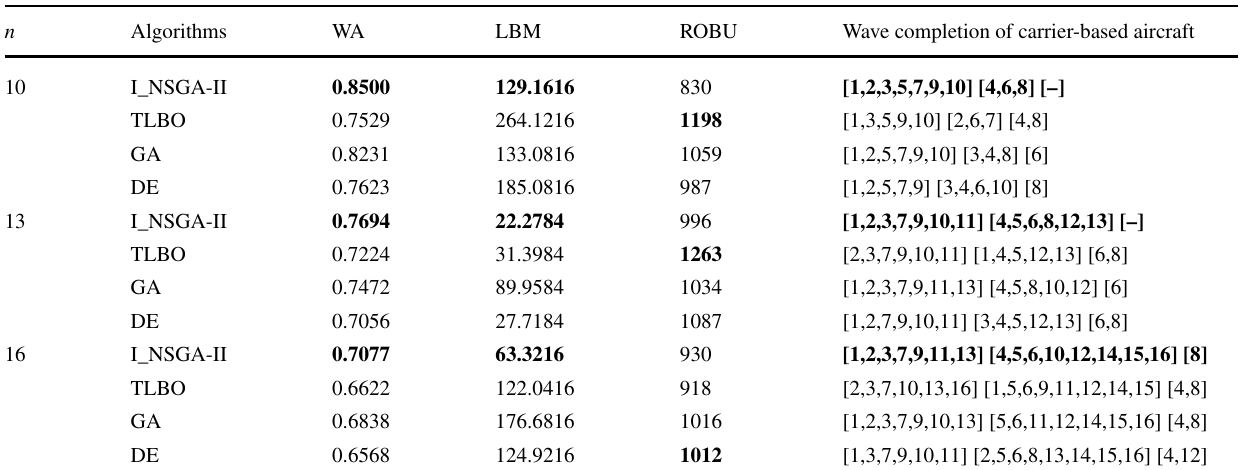
Fig. 9 Results of WA for different algorithms Table 4 Optimal solution results of different